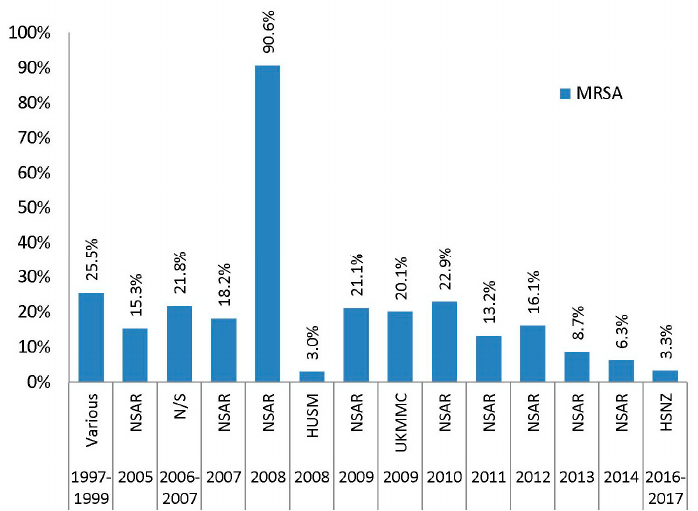
Figure 8. The prevalence of chloramphenicol resistances in Malaysian MRSA isolates, 1997–2017. Data from the NSAR reports; various, collected from ten hospitals throughout Malaysia between 1997 and 1999 [14]; not specified (N / S) between 2006 and 2007 [17]; HUSM in 2008 [19]; UKMMC in 2009 [20]; and HSNZ in 2016 and 2017 [23].